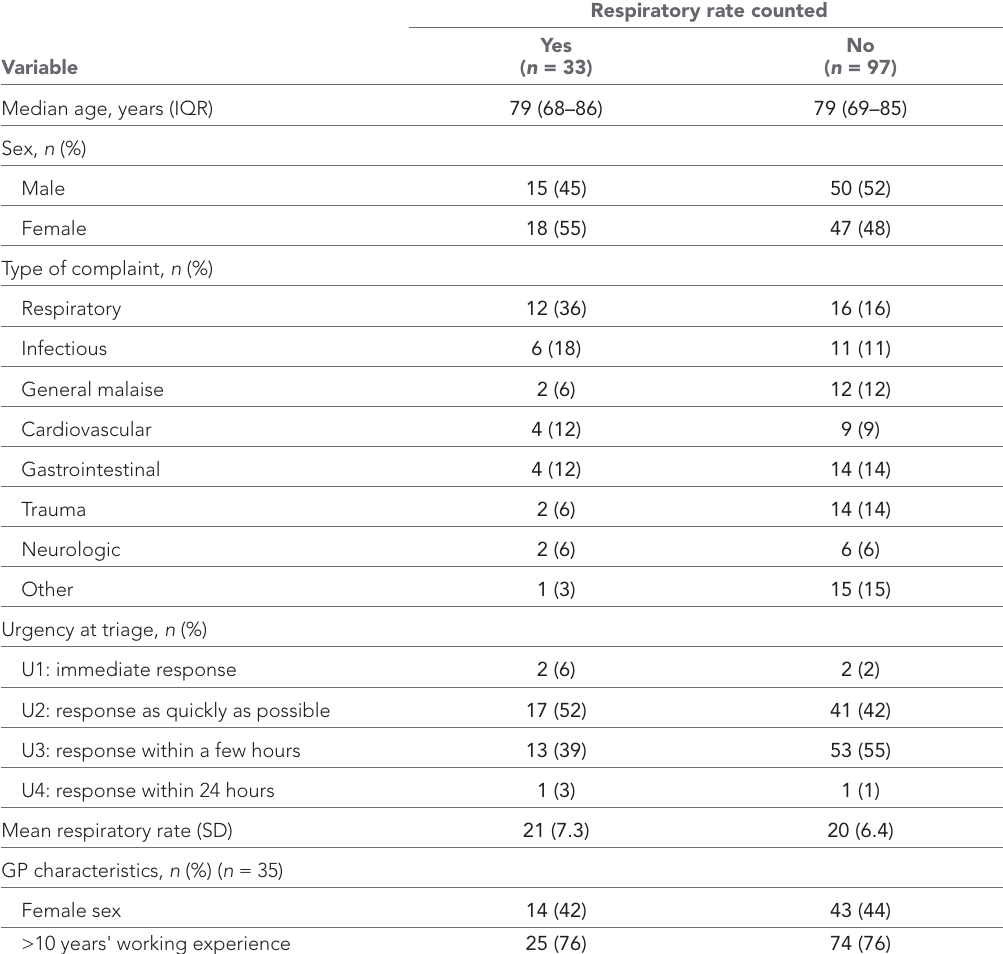
Table 1 Background characteristics of the included acutely ill patients ( n = 130), divided by patients in whom the GP did or did not count the respiratory rate for at least 15 seconds